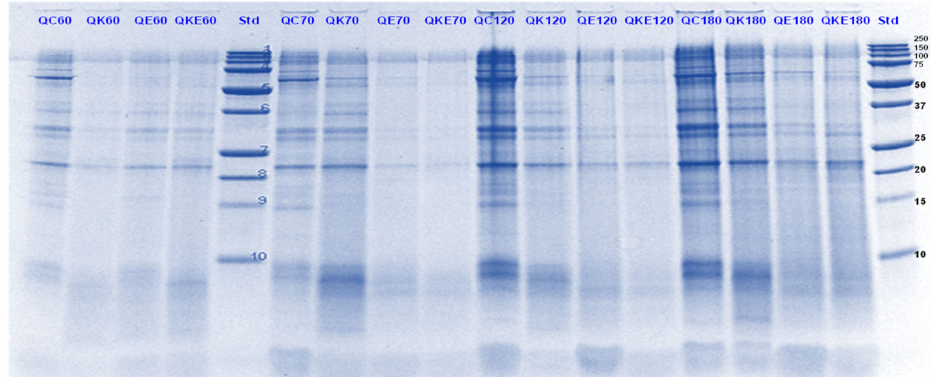
Figure 18. Tricin SDSPAGE electrophoretogram of quinoa (Q) digests after 60, 70, 120 and 180 min of simulated oral-gastric-small intestinal digestion in the presence or absence of Hayward (K) kiwifruit extract. QC, Quinoa (Q) control without any digestive enzymes; QK, with added green kiwifruit extract but no digestive enzymes; QE, with digestive enzymes but no added kiwifruit extract; QKE, with both digestive enzymes and green kiwifruit extract. The number 60 is the gastric digestion time following 2 min of oral digestion. Numbers 70, 120 and 180 are the total digestion times in oral-gastro-small intestinal digestion (including 60 min of gastric digestion). Bands (1–10) in the molecular weight standard lane correspond to molecular weights 250, 150, 100, 75, 50, 37, 25, 20, 15 and 10 kDa.